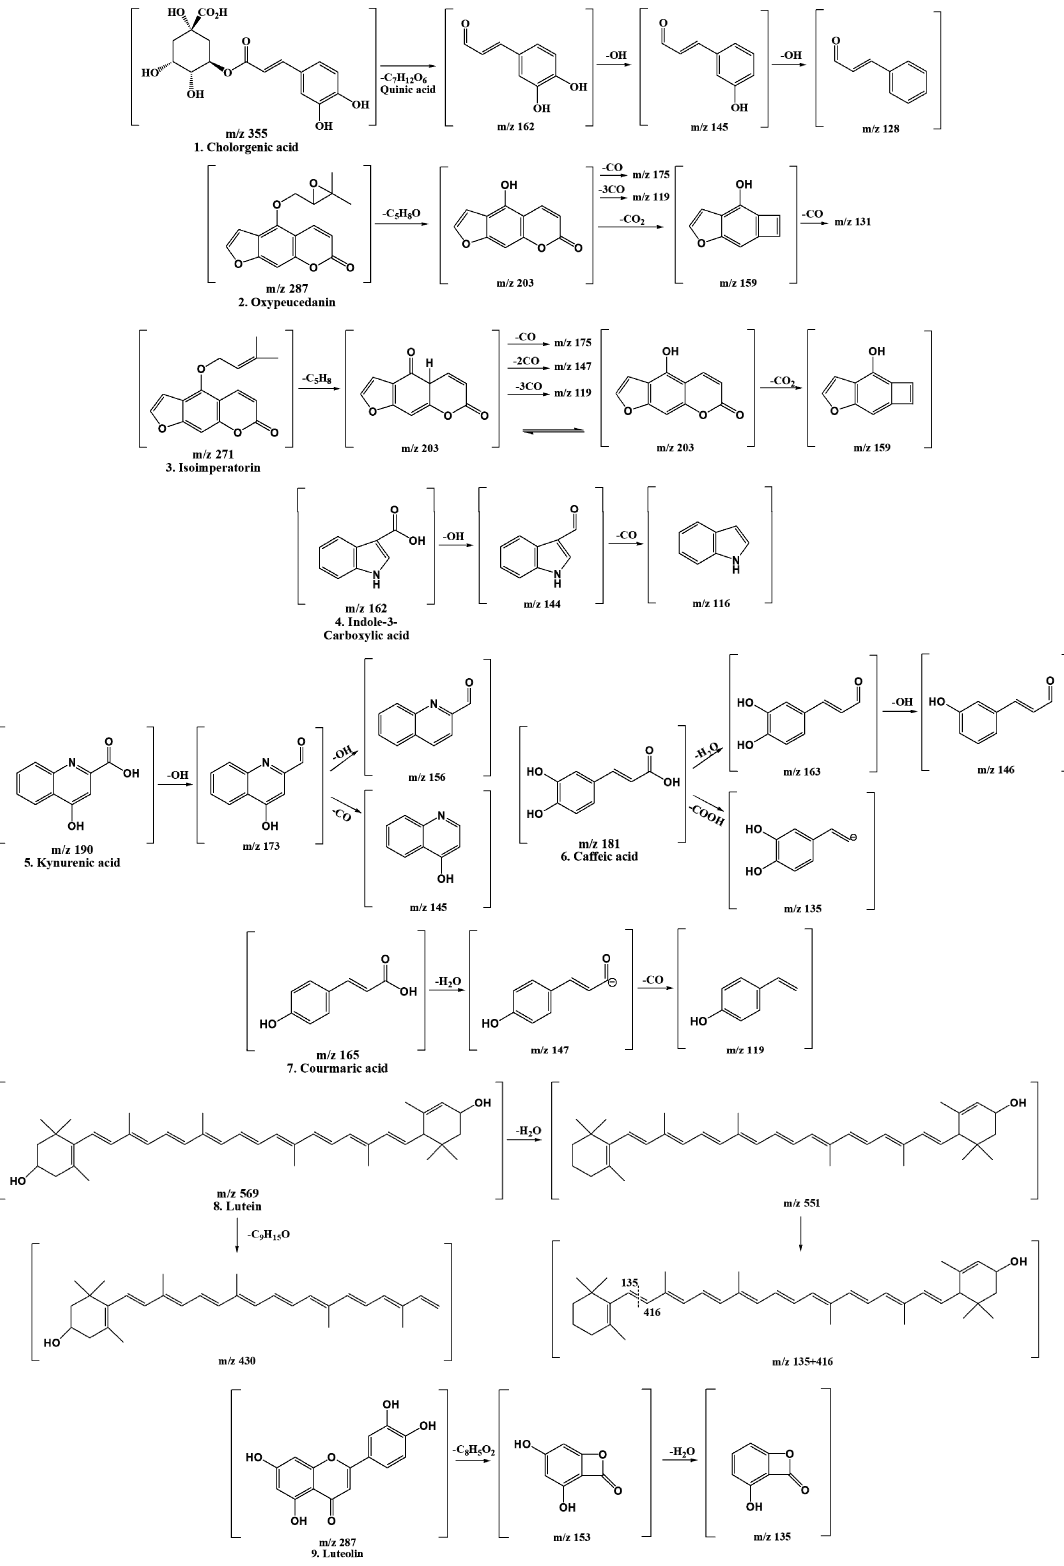
Figure 2. Fragmentation scheme of the polyphenols contained in Gynura procumbens.